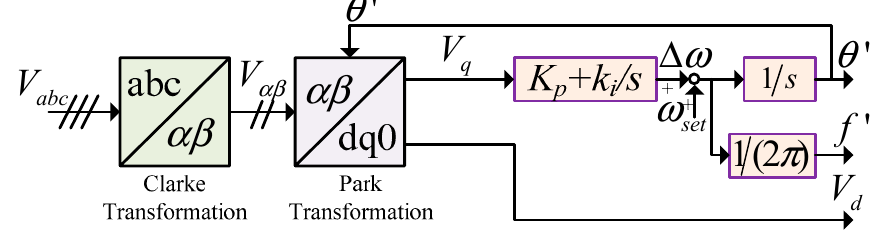
Figure 2. DQ-PLL structure.